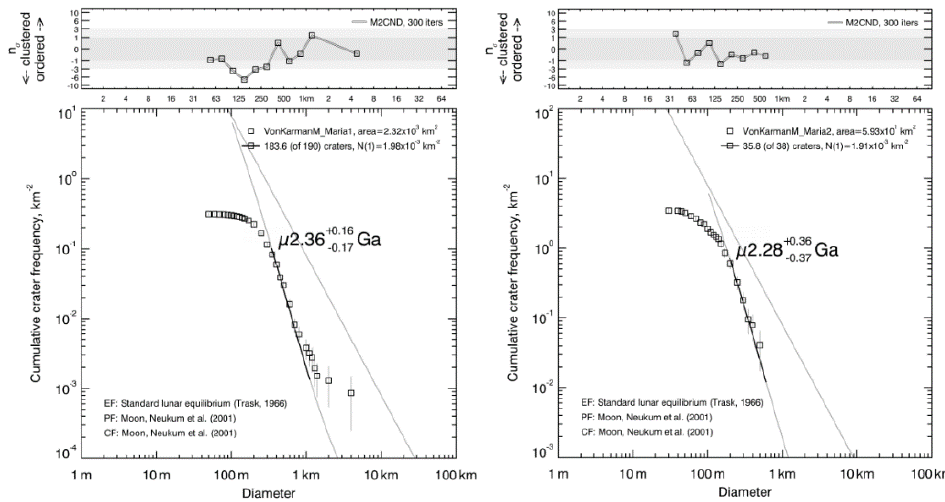
Figure 5. Dating results for basalt units in Von Kármán M crater. VonKarmanM_Maria1 and VonKarmanM_Maria2 correspond to the basalt units ‘ d ’ and ‘ e ’ in Figure 4. The equilibrium function is the standard lunar equilibrium of [35], while both the production and chronology functions are from [36].